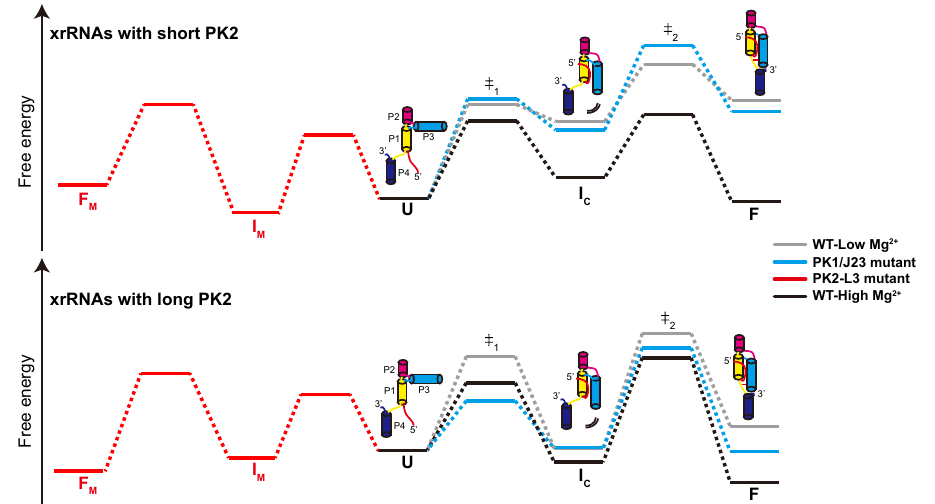
Fig. 7 The proposed folding free-energy landscape for fl aviviral xrRNAs. The folding is cooperatively sculpted by Mg 2 + and PK2 length variations. In the absence of Mg 2 + , unfolded state (U) is the most stable conformation. The addition of Mg 2 + stabilizes the intermediate (I C ) and folded state (F). Long PK2 further stabilizes F state and enhances the native state formation. Disruption of tertiary interactions including PK1 or J2/3 destabilizes the I C and F state signi fi cantly, while long PK2 at high Mg 2 + can compensate for the destabilization effect. However, the complete disruption of PK2 (PK2-L3) results in the formation of nonnative intermediates (I M ) and misfolded conformation (F M